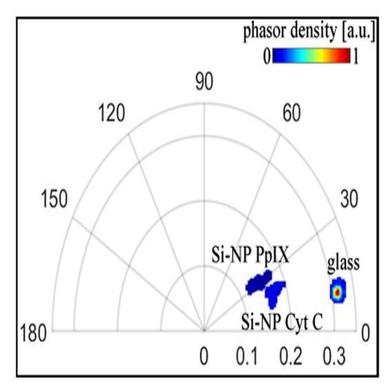
Phasor distribution density diagram computed from s-SNOM amplitude and phase images collected on silica nanoparticles doped with PpIX and with Cyt C samples deposited on glass. Besides the circular area corresponding to the phasors associated to the glass, two other areas are present in the diagram, corresponding to the phasors associated to the two types of silica nanoparticles.